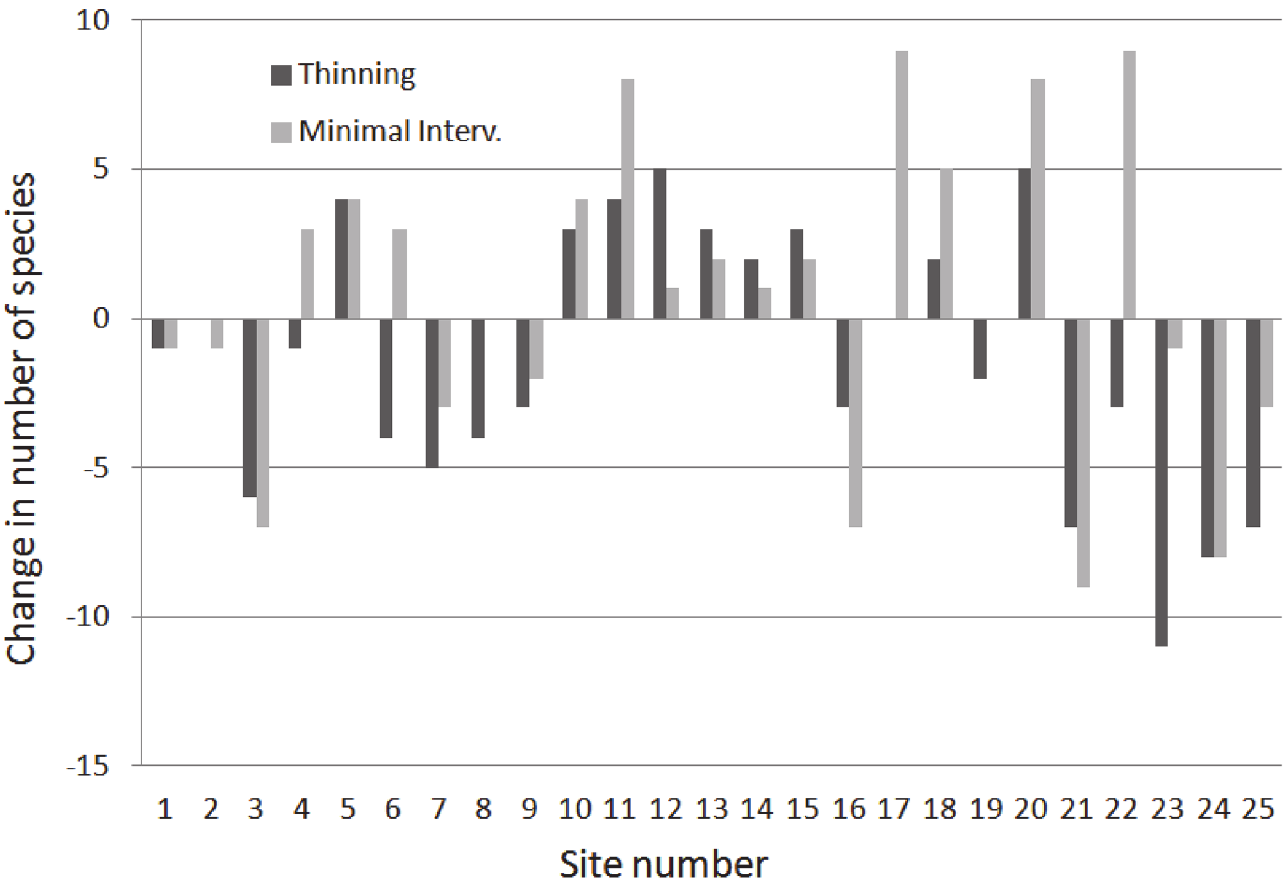
Fig 2. Changes in species richness (number of recorded species; after minus before treatment) of snails and slugs, for thinning plots and minimal intervention plots. For site number and location, see Fig.